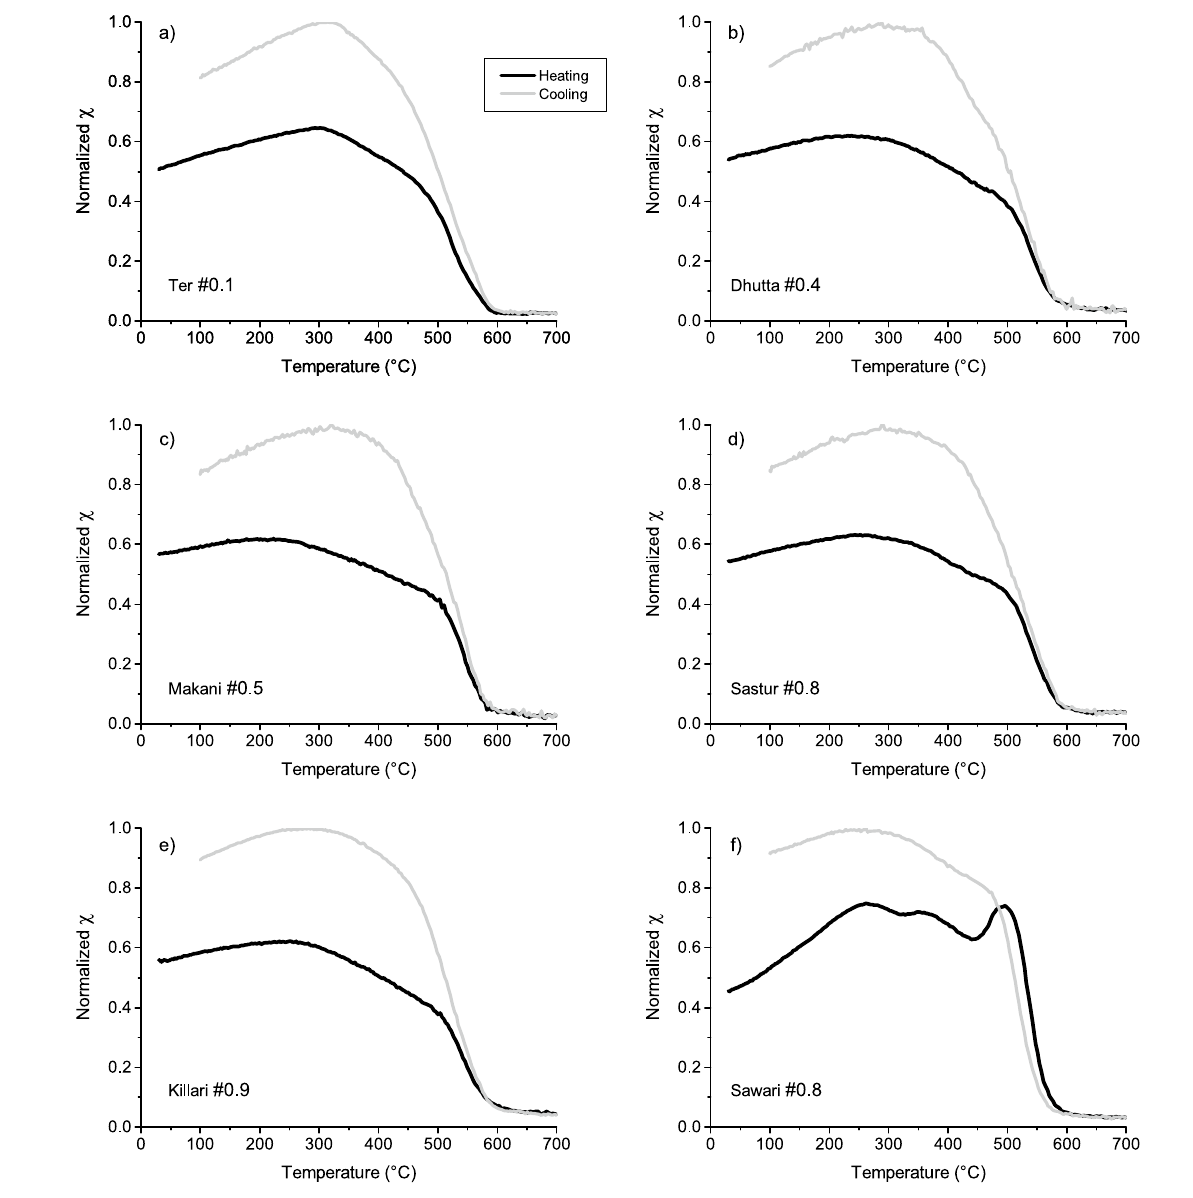
Figure 3. ( a – f ) Typical magnetic susceptibility versus temperature plots ( χ -T curves) for representative samples from different depths from six studied sections Ter, Dhutta, Makani, Sastur, Killari and